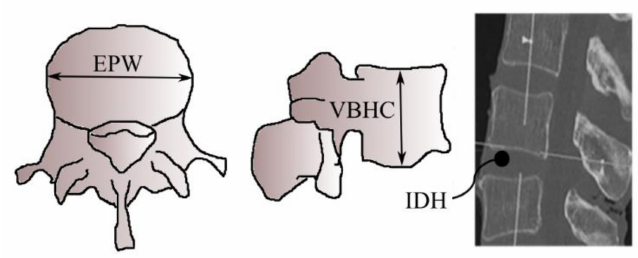
Figure 2. Typical vertebra parameters